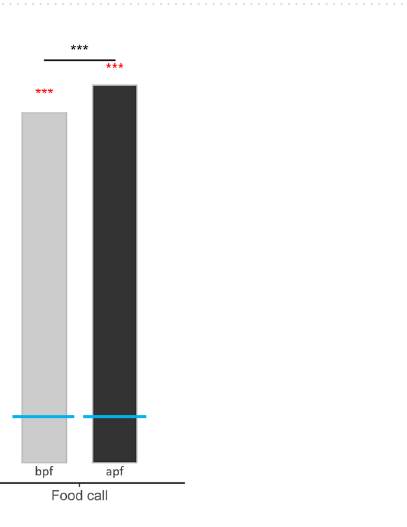
Figure 2. Relationship between the amount of accommodation and the initial vocal distance of each pair for phee-, trill-, and food calls. Significant changes in vocal distances are indicated with an *. Positive accommodation indicates convergence, i.e. that the pair became more similar, negative accommodation indicates divergence. For both trill calls and food calls, the amount of accommodation was predicted by the initial distance.